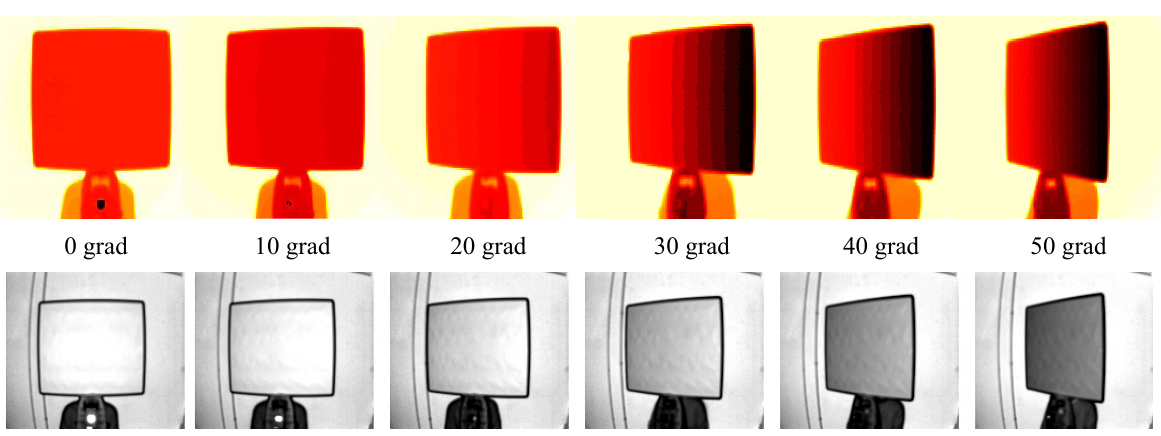
Figure 9. Range images (top) and amplitude images (bottom) acquired with different alpha angles in clockwise direction (arbitrary color scales).